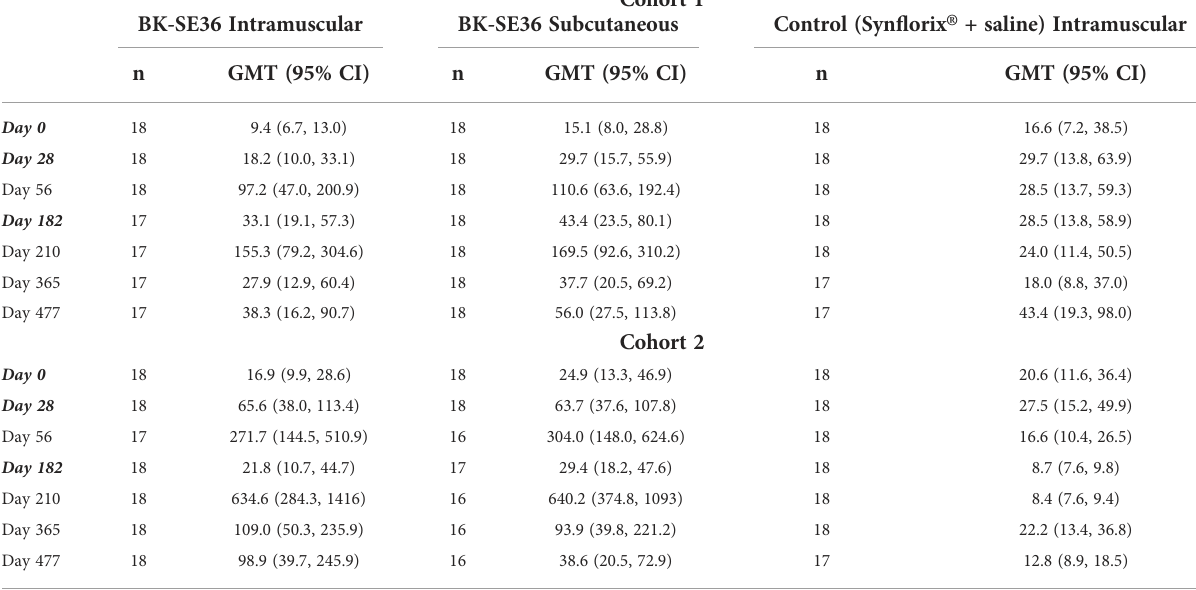
TABLE 4 Total anti-SE36 IgG antibody.